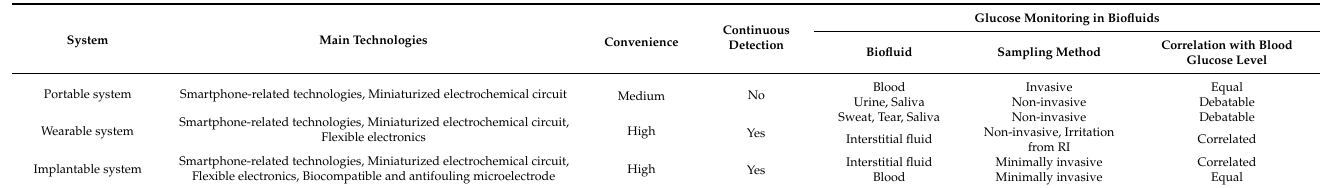
Table 6. Summary of smartphone-based electrochemical systems for glucose monitoring in